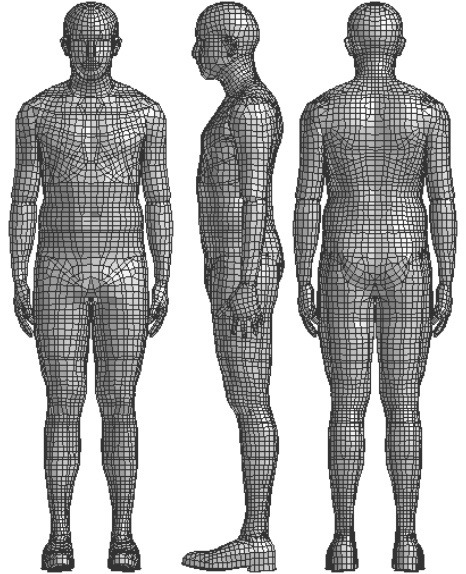
Figure 2. Reference model. Front ( left ), side ( middle ), and back ( right ) views. The reference model represents the average European anthropometry close to the Hybrid III 50% or Eurosid II dummies in terms of body dimensions. The reference model is a male with a weight equal to 77 kg and a height equal to 176 cm